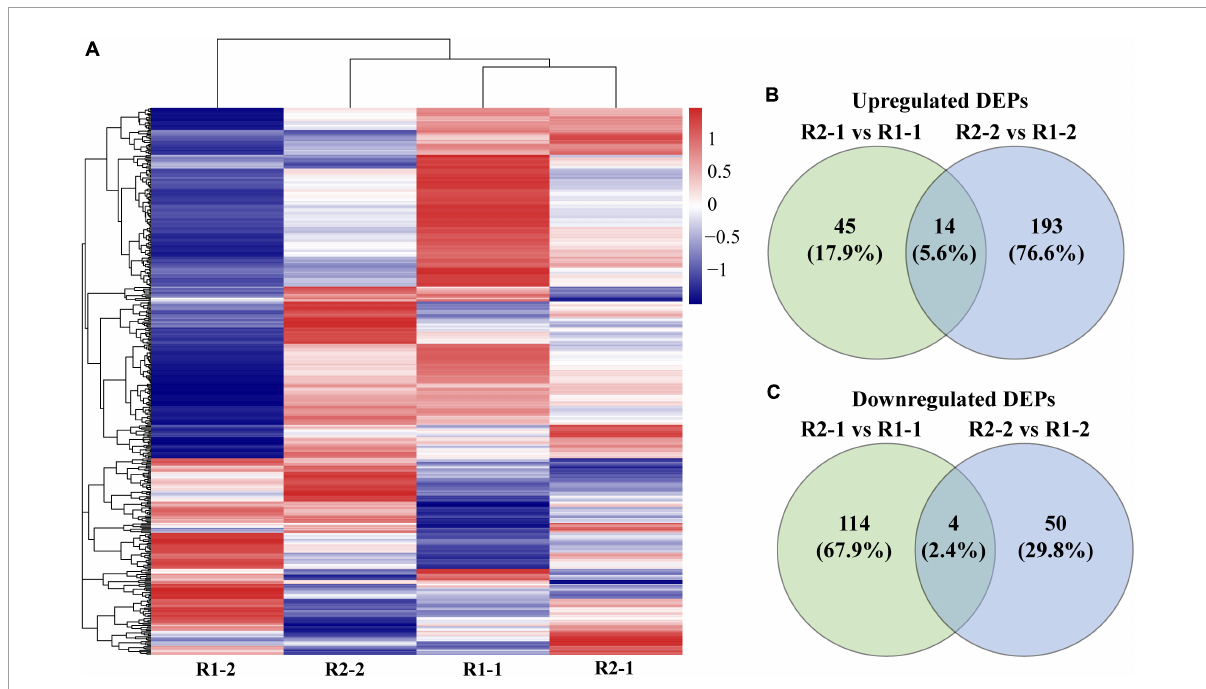
FIGURE5 Clustering heatmap of 440 identified chloroplast proteins (A) and Venn diagrams of differentially expressed proteins (DEPs) in the flag and penultimate leaf (B,C) at anthesis under different row spacing treatments. Each row represents a chloroplast protein in (A) and the gradient of red to blue colors indicates high to low relative